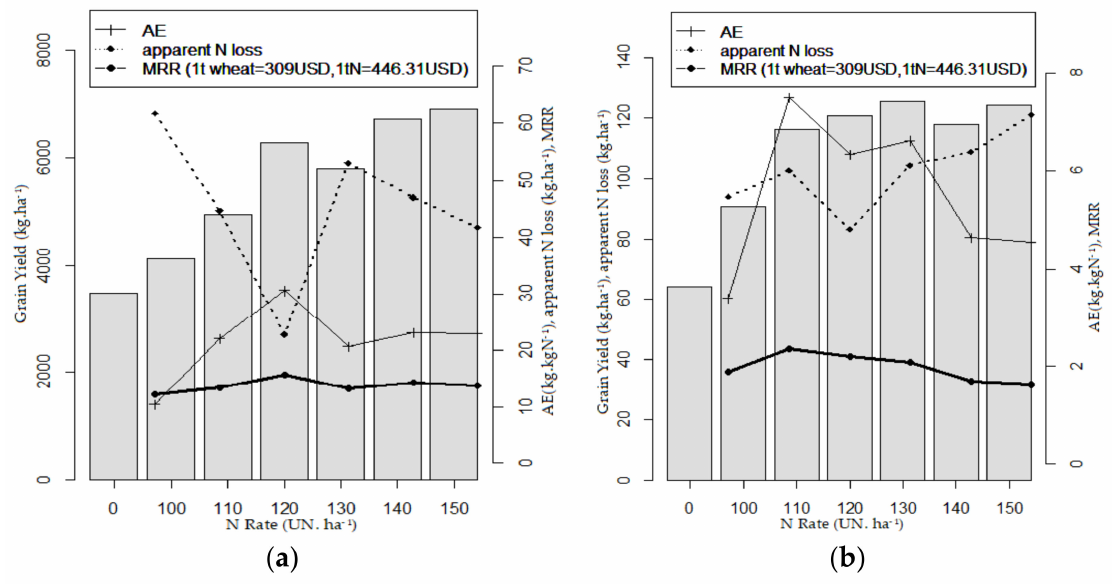
Figure 5. Nitrogen rate effects on grain yield, agronomic efficiency, apparent N loss, and marginal nitrogen return in the wet year ( a ) and the dry year ( b